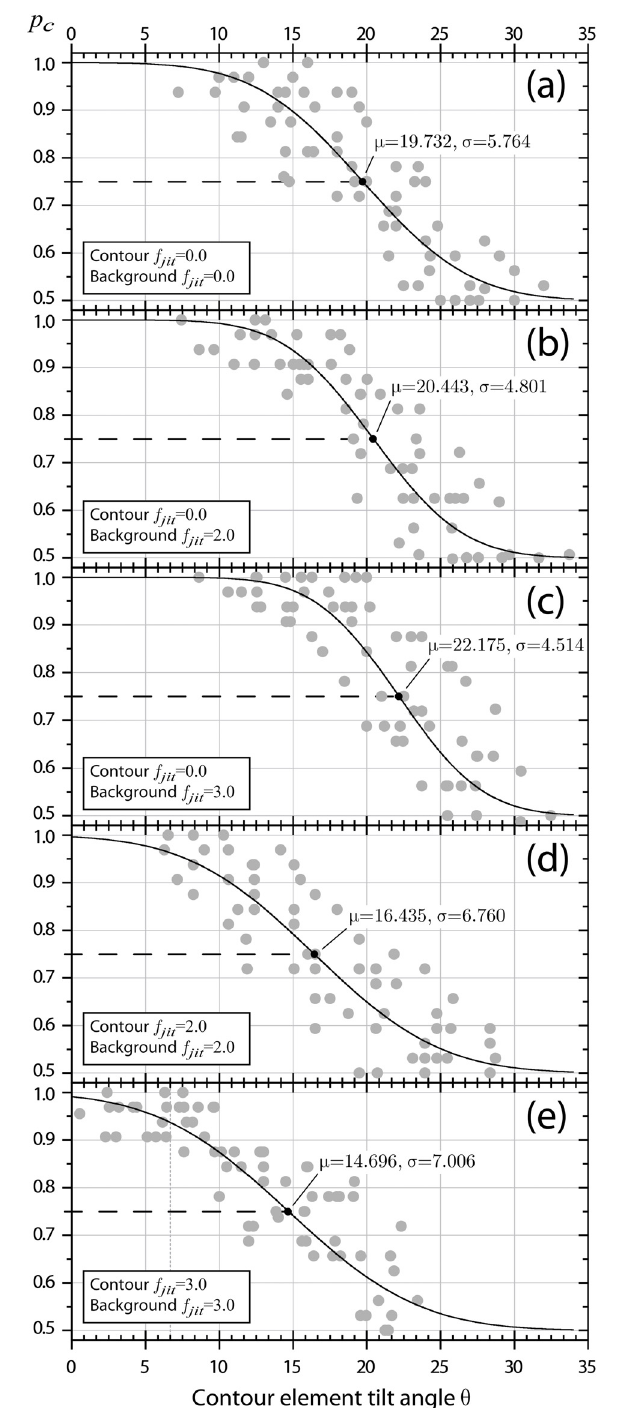
Fig 3. Psychometric functions. Fits are depicted separately for all five combinations of contour and background spatial frequency jitter. Data points represent proportion correct measures from all subjects at multiple tilt angles θ . For each experimental condition a summary psychometric curve is drawn (solid line). The curve is a cumulative Gaussian function intersecting at the between subject mean tilt angle threshold, (cid:2) m y , and with a mean standard deviation estimate, (cid:2) s y . Mean estimates are highlighted by black